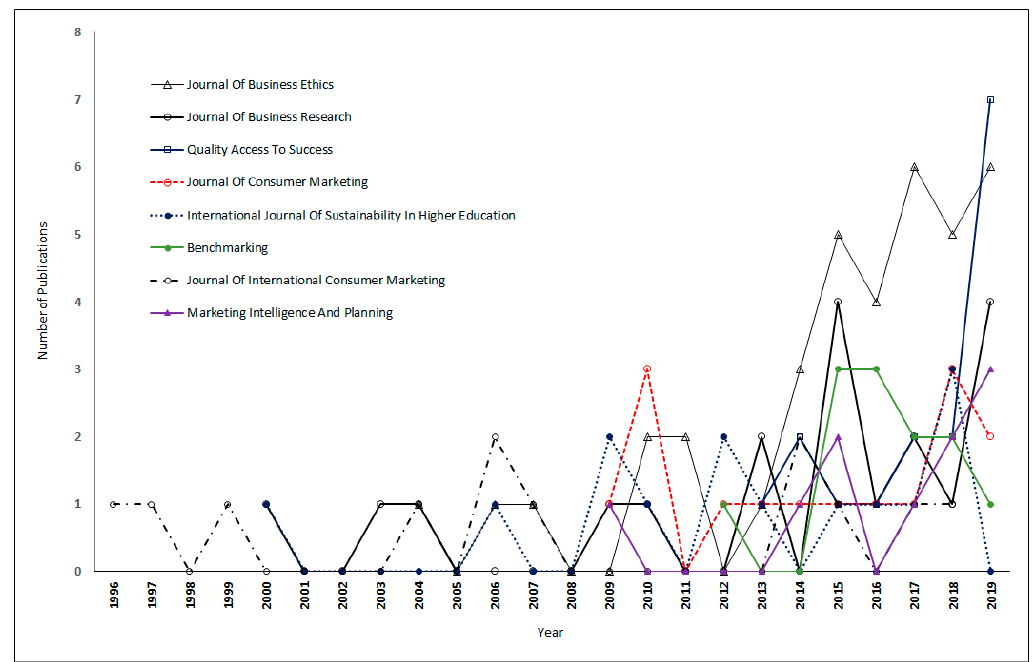
Figure 5. Yearly growth of top sources in the field of green products.